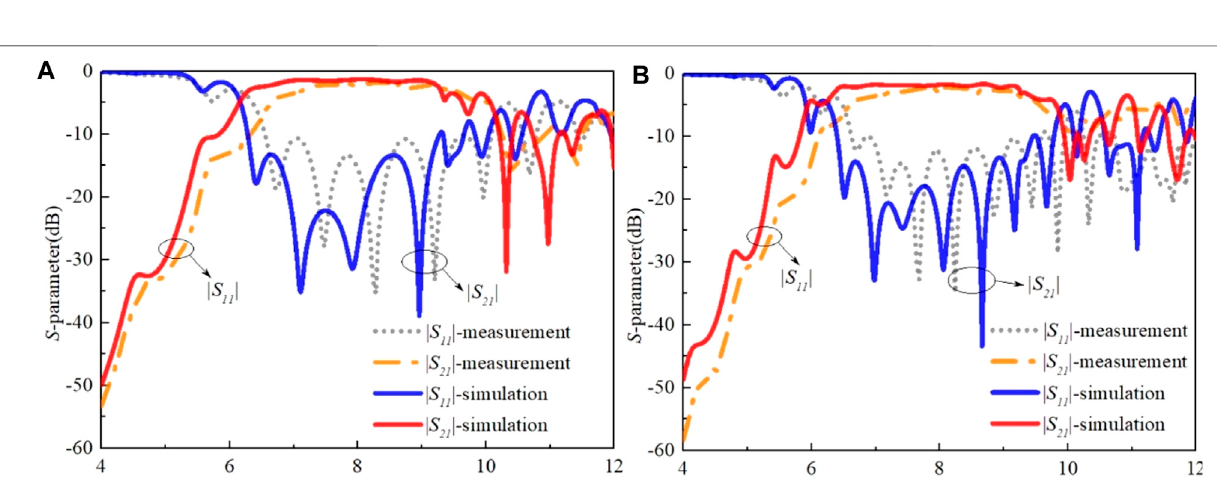
Frontiers in Physics |